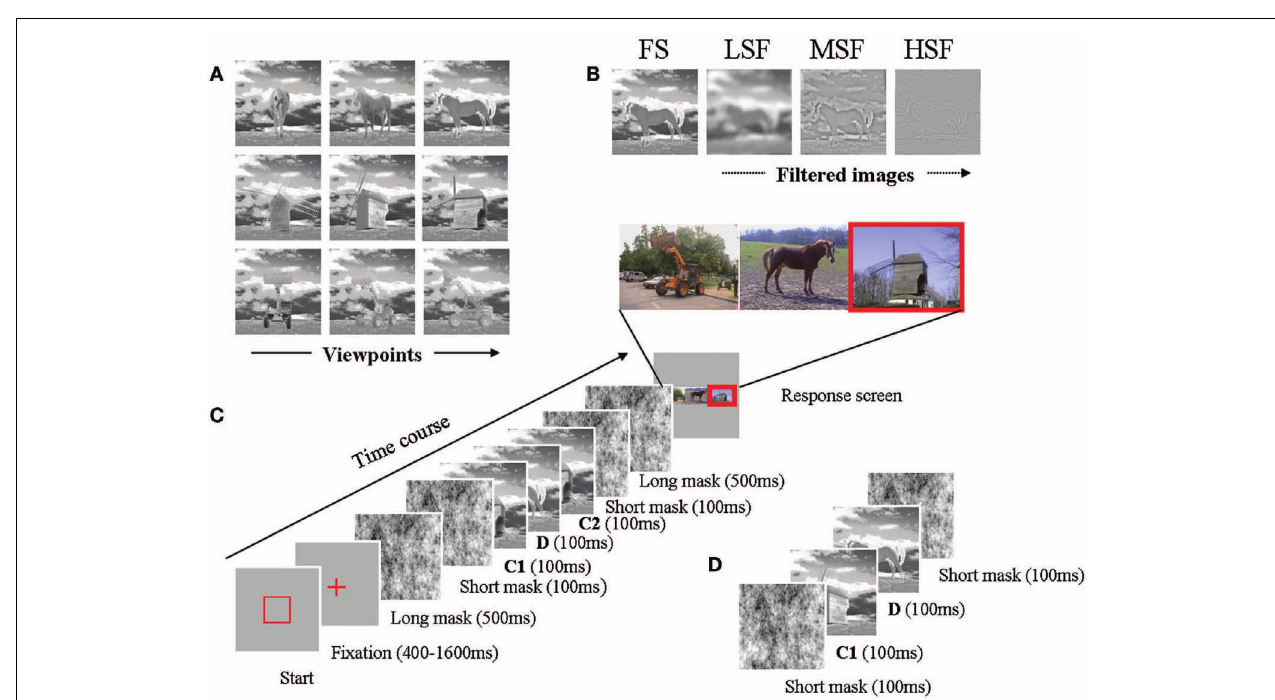
sequence consists in a succession of five pictures presented for 100ms: the first picture is a mask, followed by the first occurrence of a stimulus (C1), a distractor (D), a second stimulus C2 (second occurrence of the same object type as C1 in repeated condition, different object type in a non-repeated sequence) and another mask. Another long mask followed.The response page was then displayed. (D) Illustration of a filler sequence, in which only two objects are